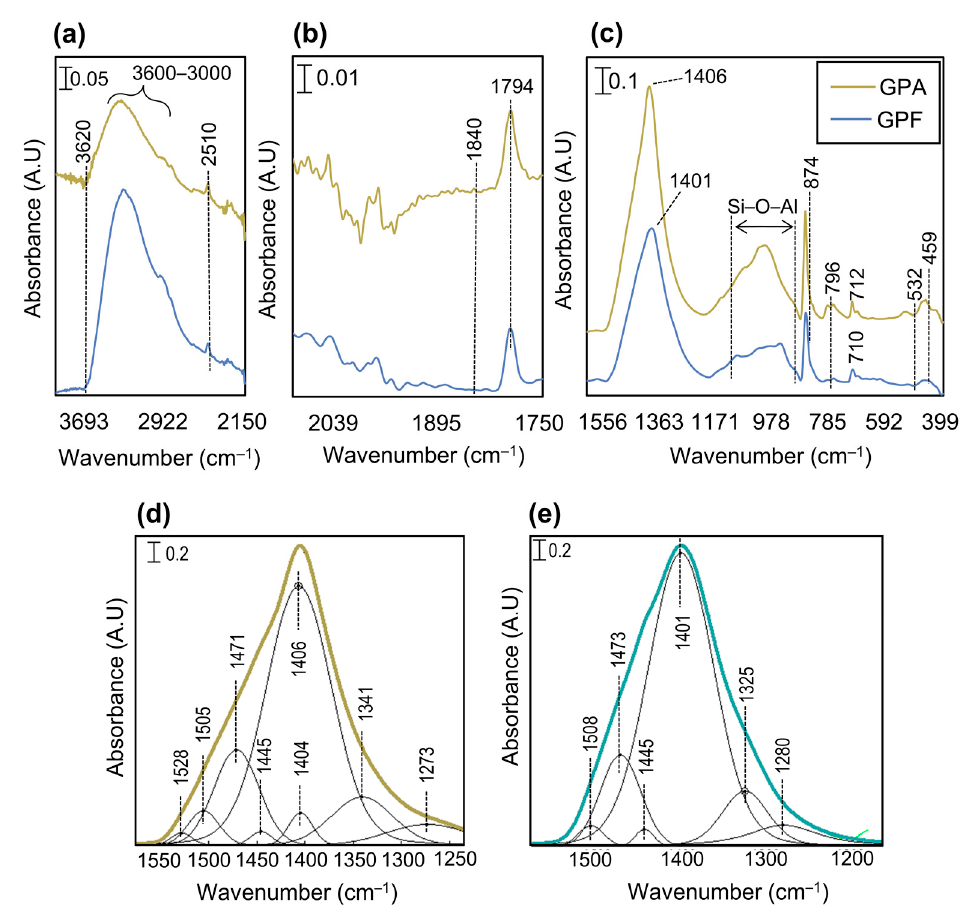
Figure 6. FTIR spectra of synthesized geopolymer composites: ( a ) 4000–2150 cm − 1 , ( b ) 2140–1750 cm − 1 , ( c ) 1600–400 cm − 1 and deconvoluted spectra between 1600 and 1200 cm − 1 for GPA ( d ) and GPF ( e ). Note that the black plots in ( d , e ) are deconvoluted peaks.